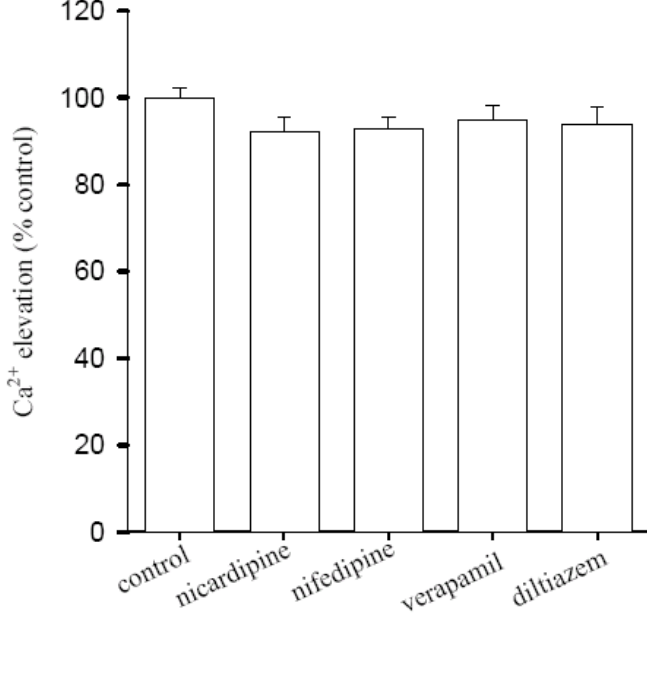
Figure 4. Effect of Ca 2+ channel blockers on [10]-gingerol-induced [Ca 2+ ] experiments were performed in Ca 2+ -containing medium. The data are presented as the percentage of the control, which is the net area under the curve (30-250 sec) of the [Ca 2+ ]